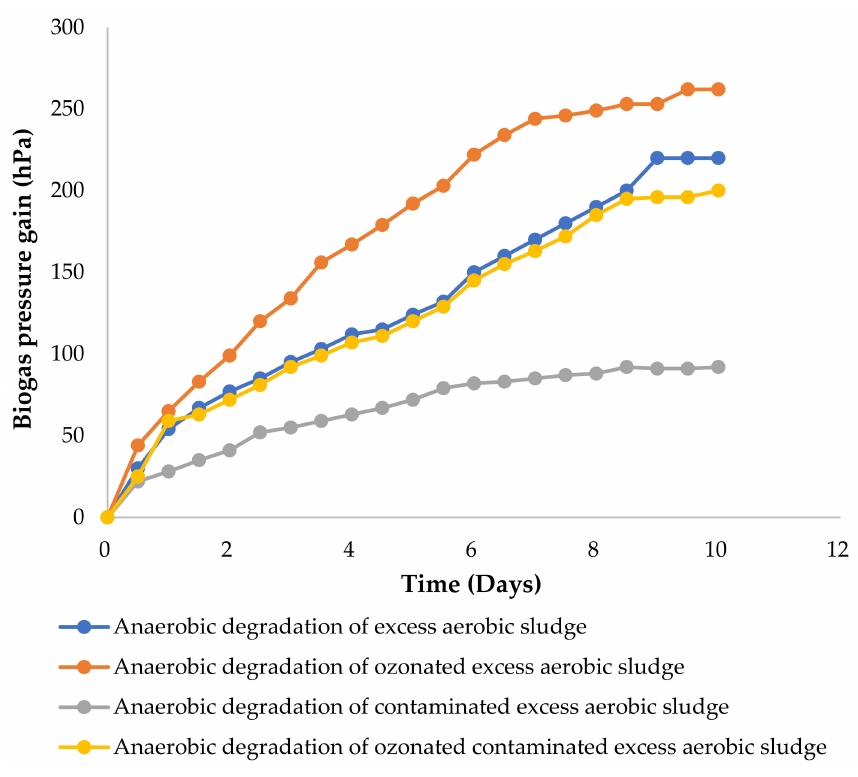
Figure 4. Biogas production in a system with aerobic sludge, ozonated aerobic sludge, aerobic sludge contaminated with model antibiotic, and ozonated contaminated aerobic sludge: Illustration of the